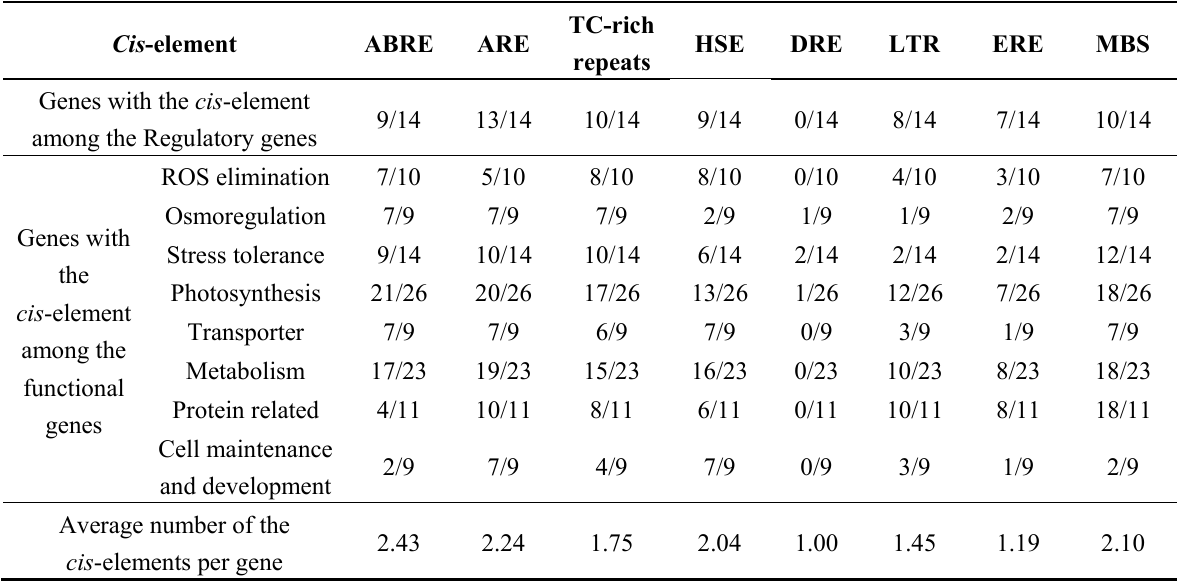
Table 2. The presentation of the cis -elements in the salt-responsive gene in Malus zumi